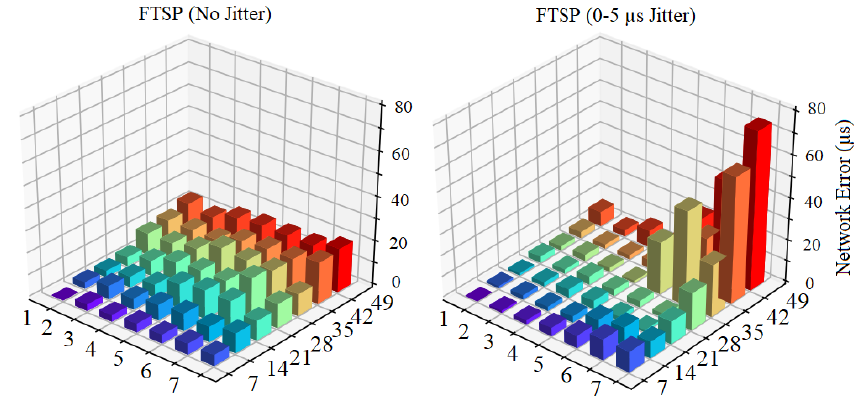
Figure 3. Synchronization error between reference node (at 1 × 1) and other nodes in grid topology in two settings: without message delay and with the message delay jitter up to